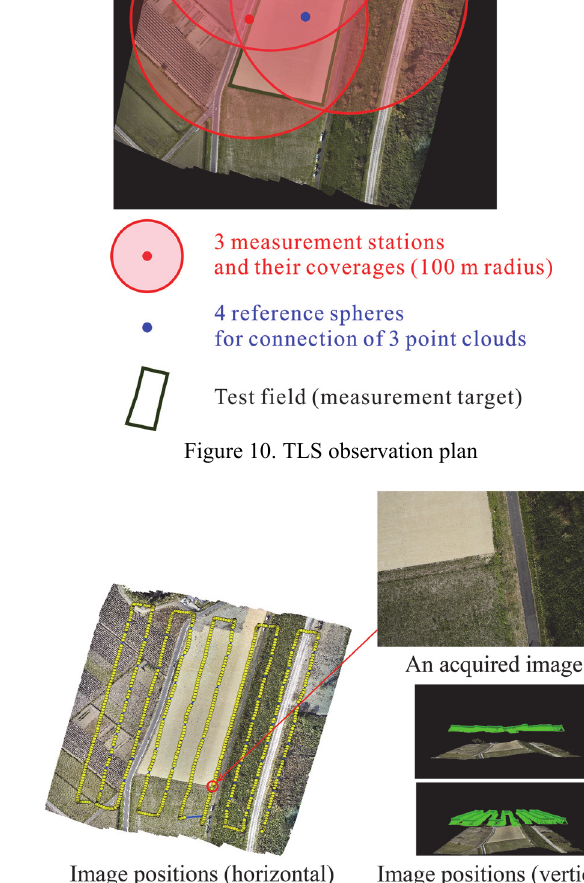
Figure 11. Flight number 1 by QC730 with 